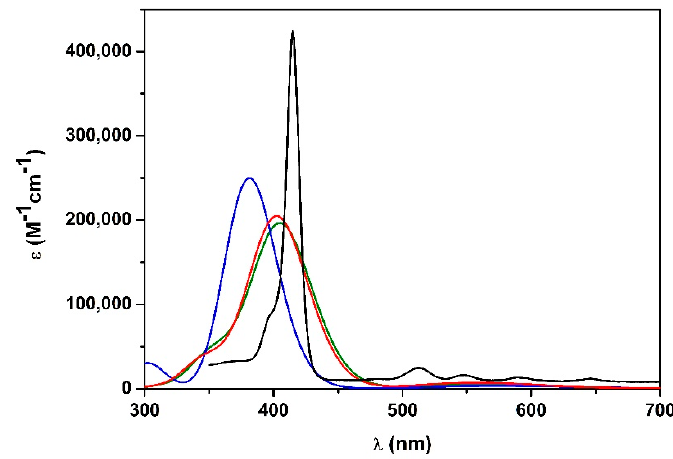
Figure 4. Calculated UV-vis spectra in EtOH of 1H 2 with: B3LYP functional 6-311G(d,p) basis set (green line), CAM-B3LYP functional 6-311G(d,p) basis set (red line), WB97XD functional 6-311G(d,p) basis set (blue line). Experimental UV-vis spectrum of 1H 2 in EtOH is represented with the black line.